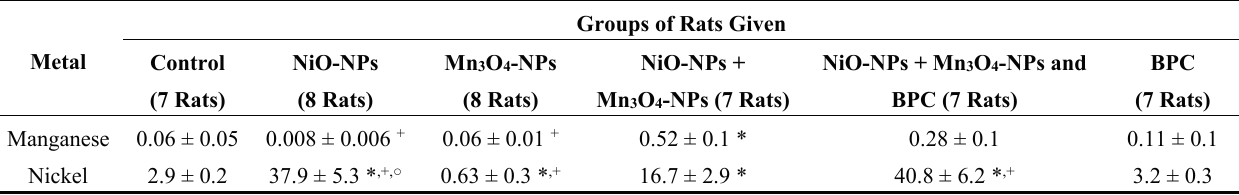
Table 2. Total manganese and nickel renal excretion in rats after repeated